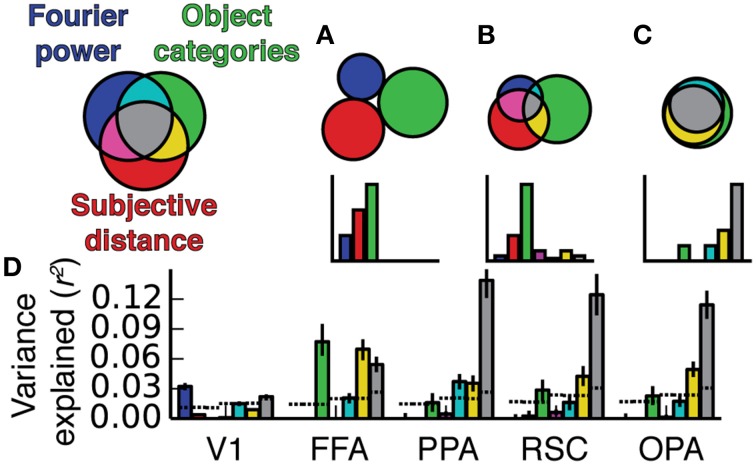
Three-way variance partitioning analysis. (A) Venn diagram representing hypothetical relationships between the variance explained by the three models, such that each explains a unique component of the variance. (B) A different hypothetical relationship in which the semantic category model explains a large fraction amount of independent variance, but the three models all share small amounts of variance. (C) A third possible relationship in which all three models explain shared variance, and the Fourier power and subjective distance models account for most of the variance explained by the object category model. (D) Three-way variance partitioning results obtained in our experiment. This plot is based on concatenated data for all four subjects; results for individual subjects are shown in Figure S08. Dotted lines at the bottom of the graph indicate chance thresholds (bootstrapped p = 0.05) for the amount of variance explained. Chance thresholds differ depending on the number of voxels per ROI and the number of subtractions between fit models necessary to compute each component of the variance. Error bars are 99% confidence intervals across all voxels in a region. The pattern of results is most consistent with the Venn diagram in (C).